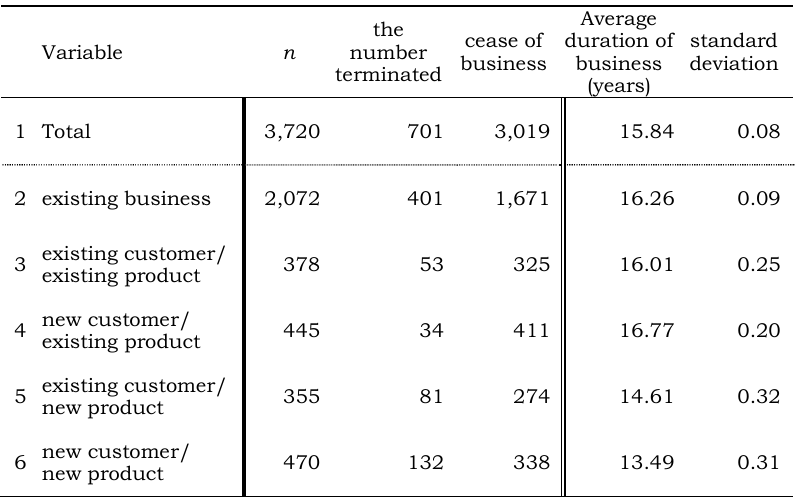
Table 1. Descriptive